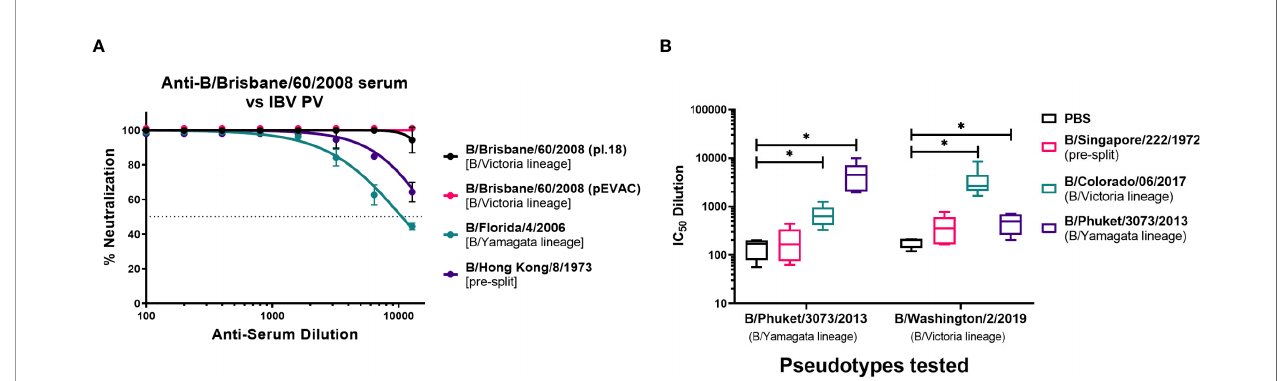
FIGURE 4 | Neutralization of in fl uenza B pseudotypes by reference antisera and mouse sera from in fl uenza vaccination studies. (A) Neutralization of pseudotypes from pI.18, B/Brisbane/60/2008, B/Florida/4/2006, and B/Hong Kong/8/1973 against reference antisera anti-B/Brisbane/60/2008 (NIBSC 11/36) was measured by a luciferase reporter assay. Reference sera was serially diluted two-fold from a starting dilution of 1:100. 1.0x10 6 RLU of IBV PV was then added to each well. For all plots, each point represents the mean and standard error of four replicates per dilution. (B) In vitro neutralization of in fl uenza B pseudotypes from pEVAC, B/Phuket/3073/2013 and B/Washington/2/2019 by mouse sera vaccinated with In fl uenza B HA from B/Singapore/222/1972, B/ Colorado/6/2017, B/Phuket/3073/2013, and PBS (negative control). Neutralization was determined via a luciferase-reporter assay and given as IC 50 dilution values (In this case, IC 50 is half maximal inhibitory serum dilution). Signi fi cant difference between the means of the IC 50 values of the groups vaccinated with IBV HA against the PBS negative control group are shown via brackets (*p<0.05). Interleaved box plots show minimum, maximum, and mean values. Error bars show standard deviation of replicates. For mice vaccinated with B/Singapore/222/1972 HA, n = 5 mice/group; n = 6 mice/group for mice vaccinated with B/ Colorado/6/2017 HA, B/Phuket/3073/2013 HA, and